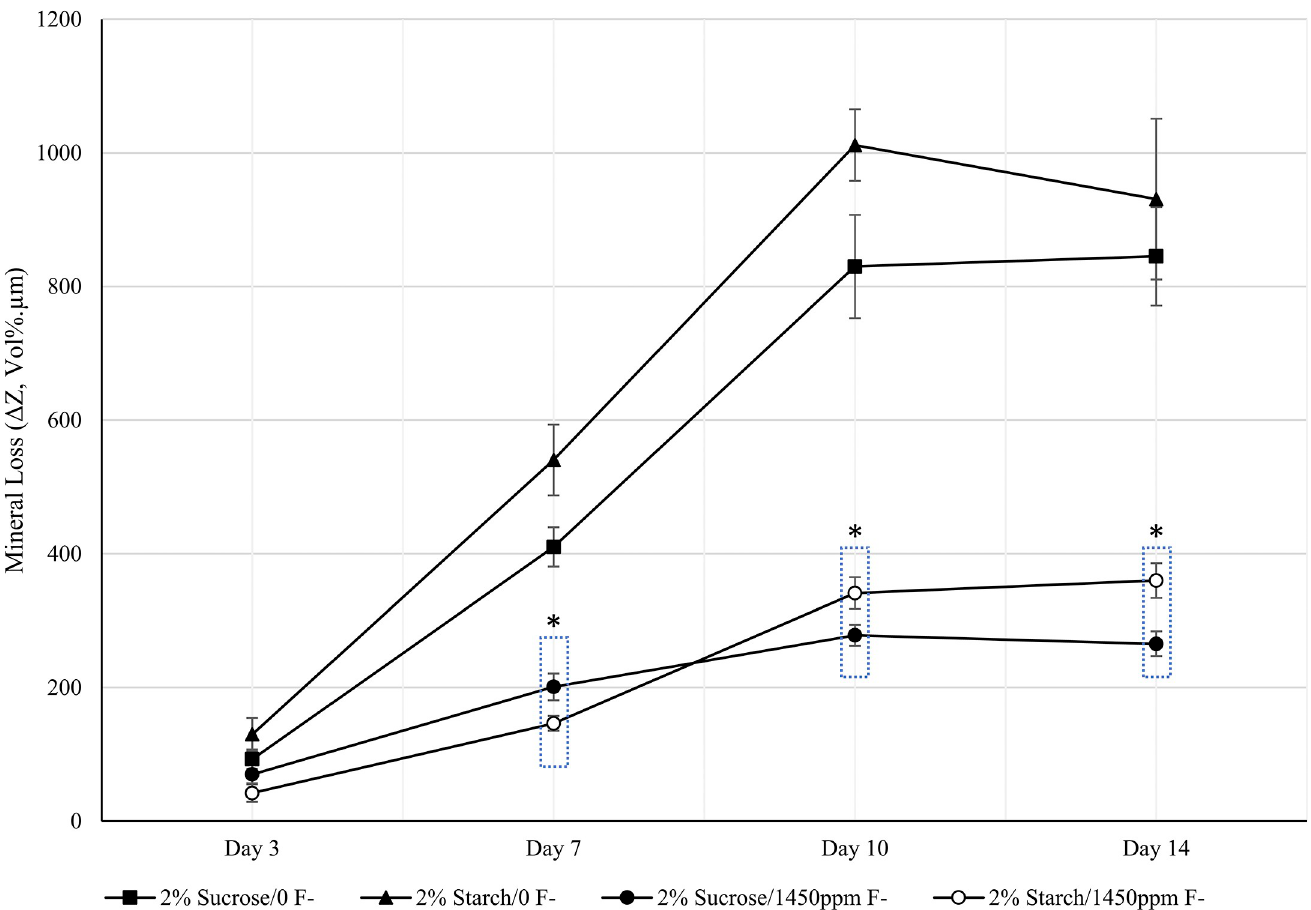
Fig 5. Changes in mineral loss. Mineral loss ( Δ Z, Vol%. μ m) over 14-days of exposure to 2% sucrose or 2% starch eight times daily. Two CDFF units were exposed to 1450 ppm F- and two units had no additional F-. Error bars represent standard error of the sample set. � Denotes